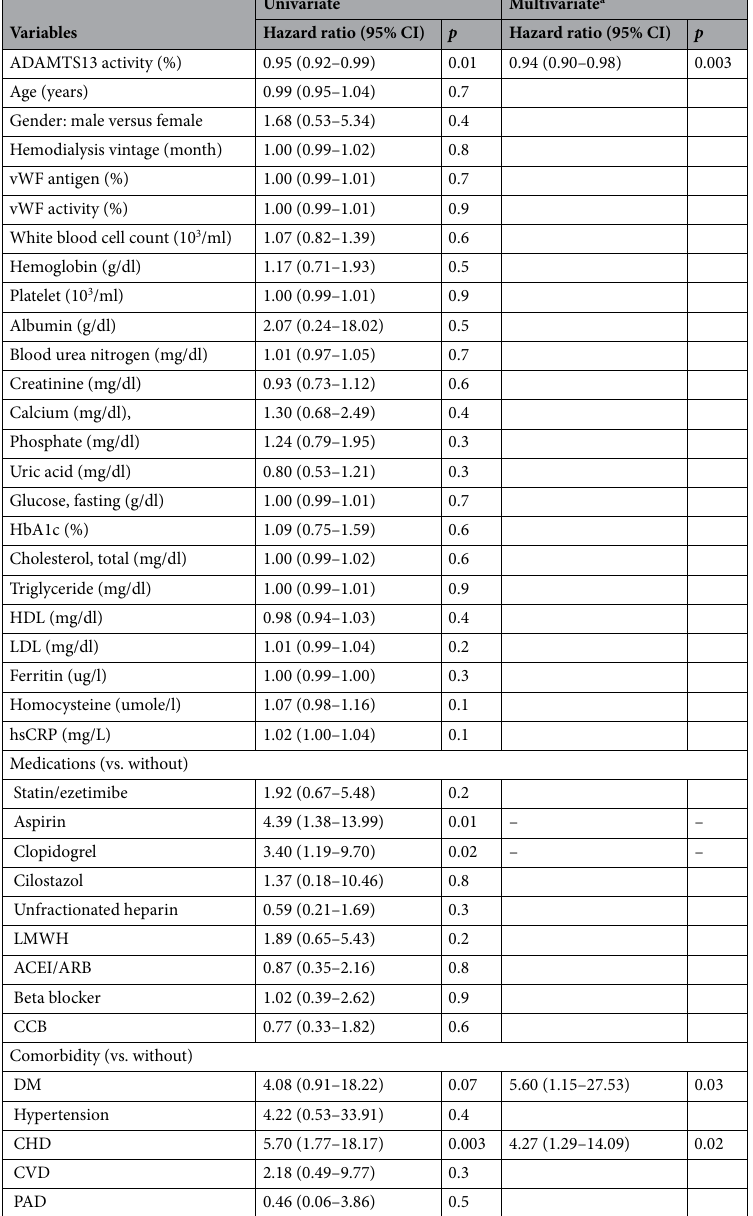
Table 2. Univariate and multivariate Cox proportional hazards models for the occurrence of new cardiovascular events in the 2-year follow-up period for 98 chronic hemodialysis patients. vWF = von Willebrand factor, HbA1c = hemoglobin A1c, HDL = high-density lipoprotein cholesterol, LDL = low-density lipoprotein cholesterol, hsCRP = high sensitivity C-reactive protein, LMWH = low molecular weight heparin, PAD = peripheral artery disease. a Variables with a p value < 0.1 in univariate analysis were selected into the multivariate analysis by using the method of “forward stepwise selection” including ADAMTS13 activity, CHD, DM, current uses of clopidogrel and